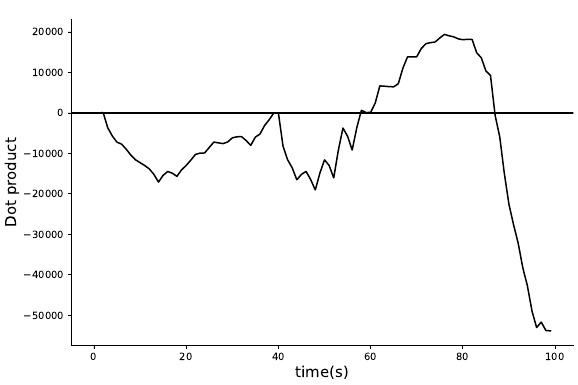
Figure 4. The dot product of signals at each time